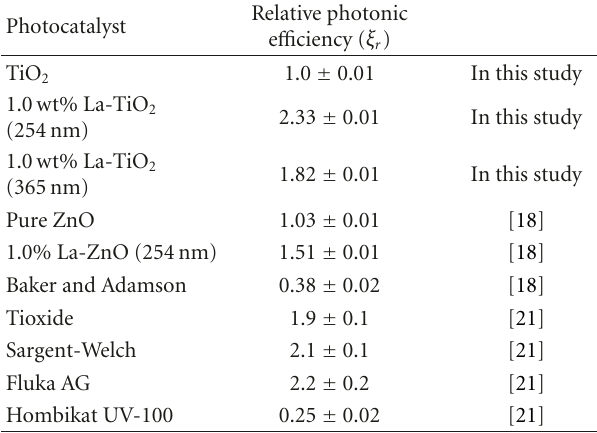
Table 5: Comparison of relative photonic e ffi ciencies in the photocatalytic degradation of MCP by pure and La-doped semicon- ductors (TiO 2 and